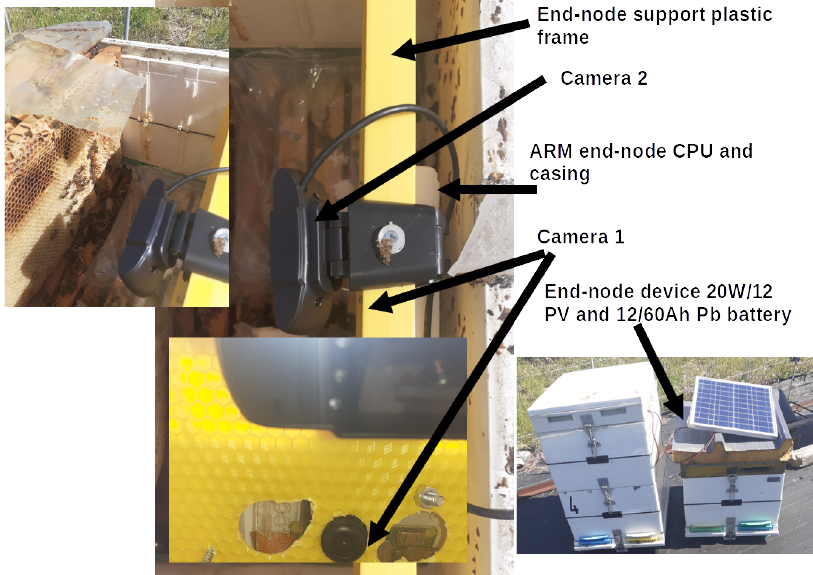
Figure 1. Proposed Varroa mite detection system end-node device and device